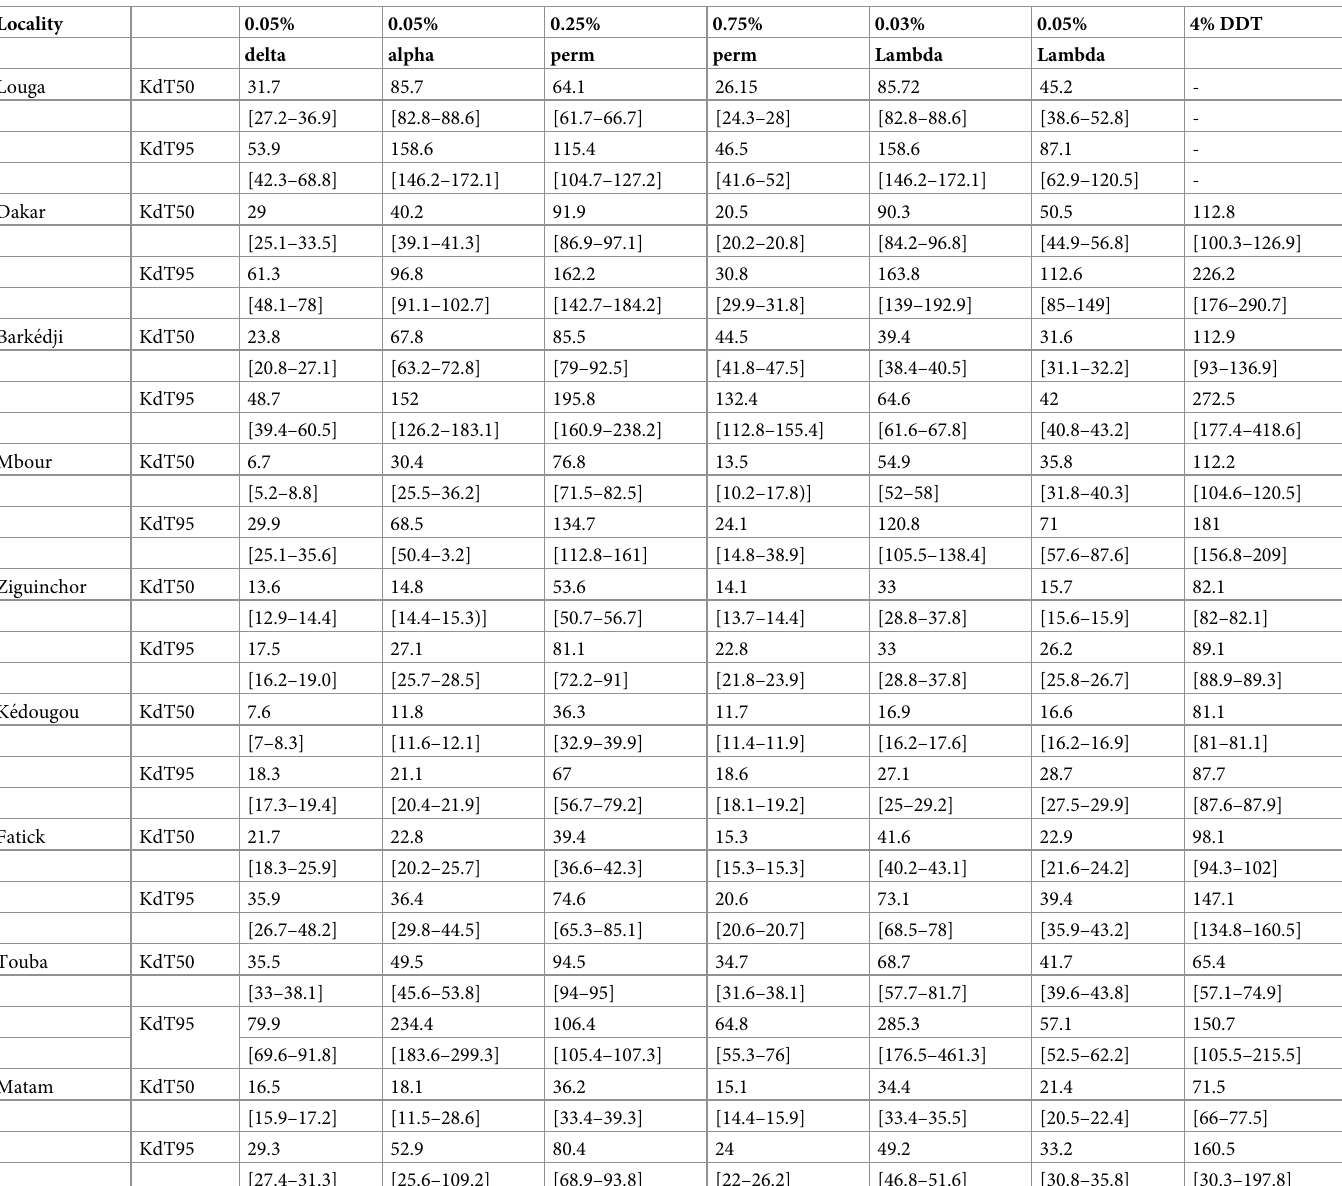
Table 1. Knockdown time (KDT50 and KDT95) of Ae . aegypti populations during the 1hour exposure to pyrethroids and organochlorines.